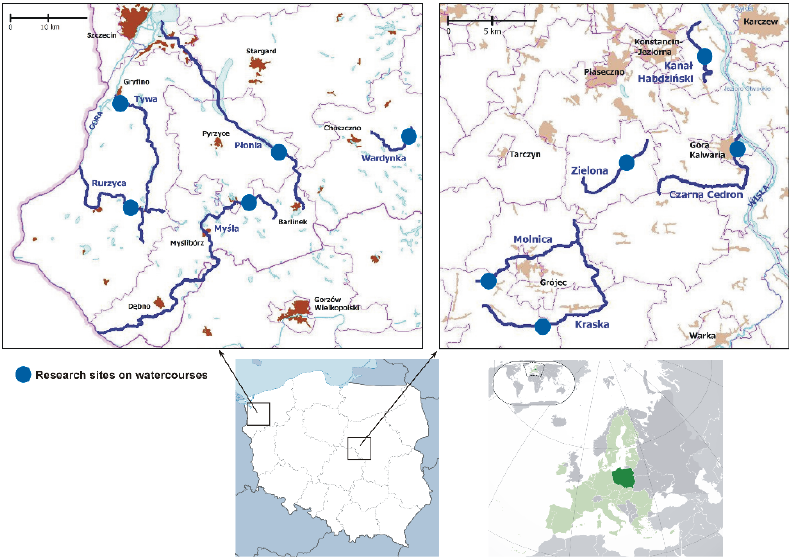
Figure 1. Study areas within the ecoregion of the European Central Plains. Lower right panel, Poland (dark green); lower left panel, location of two study areas with Poland; upper panels, locations of the study areas (blue circles).